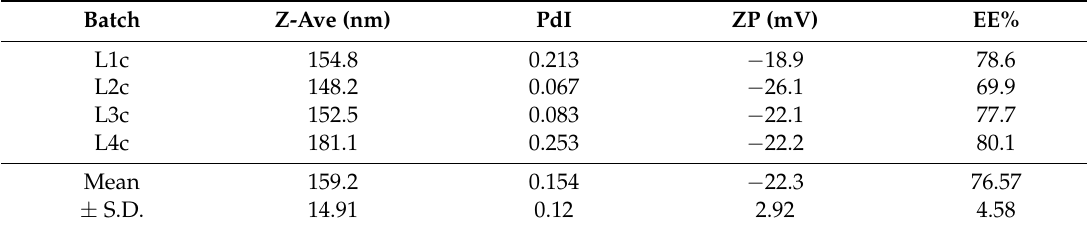
Table 2. Experimental data for calcein-loaded nanoparticles.